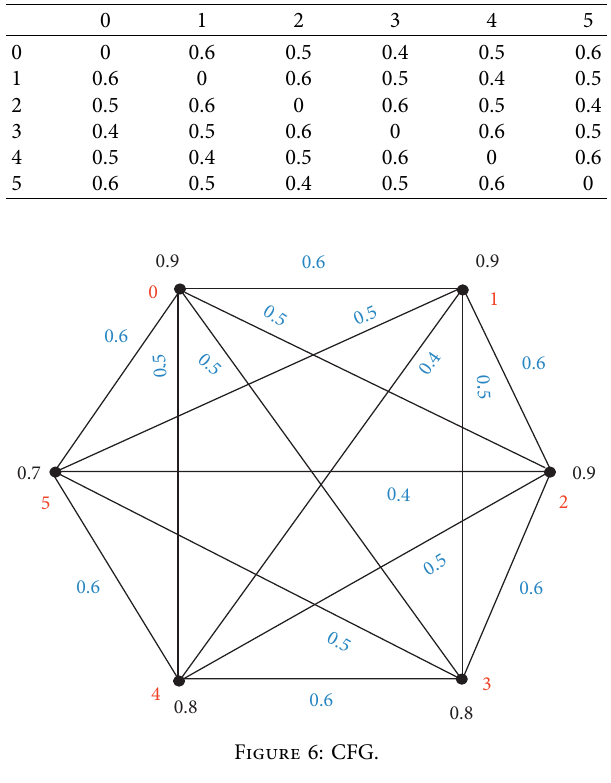
Table 3: Te use of technology corresponding to Figure 5.